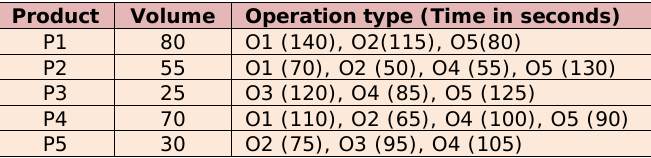
Table 1. Weekly product volumes and disassembly tasks